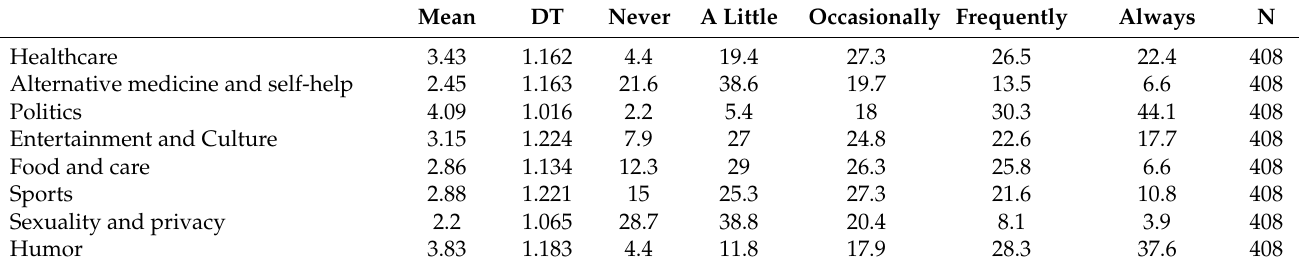
Table 4. Basic statistics for (V 4 ): what kind of information have consumed the most since COVID-19 occurred? Own elaboration.